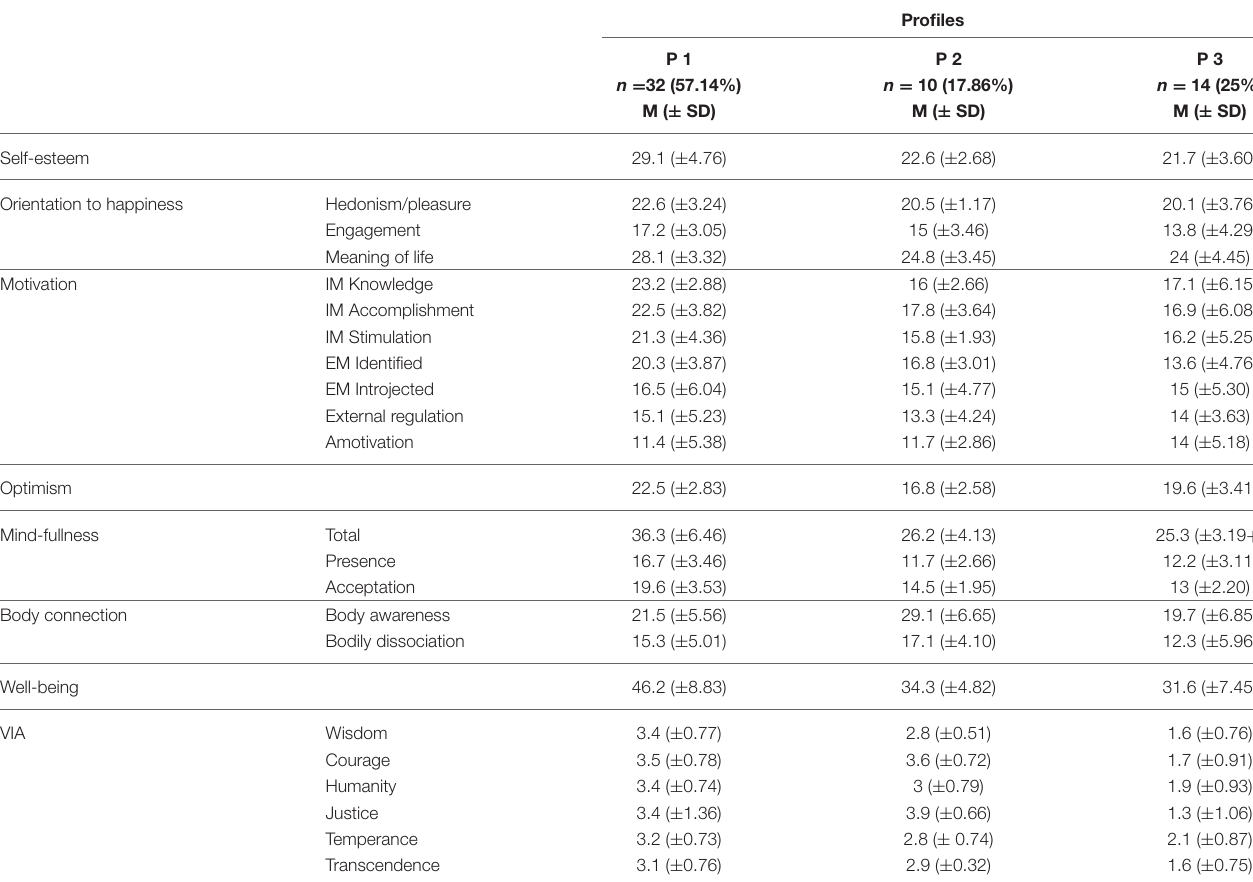
TABLE 2 | Psychological scores in the pre-HRT session according to the three profiles obtained by the mix Ascending Hierarchical